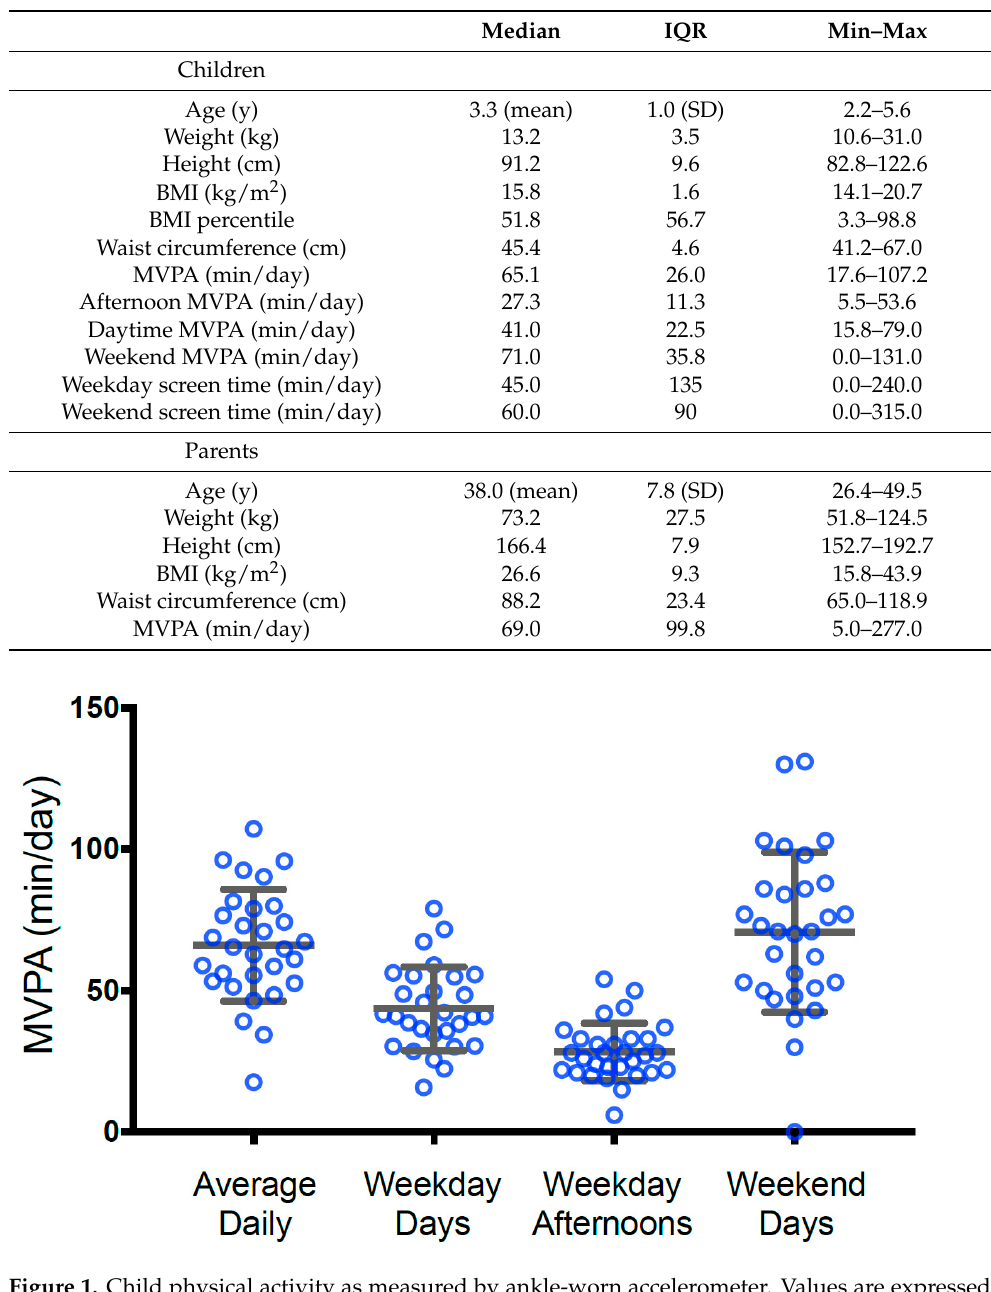
Table 1. Characteristics of the study sample (median and interquartile range except where indicated).